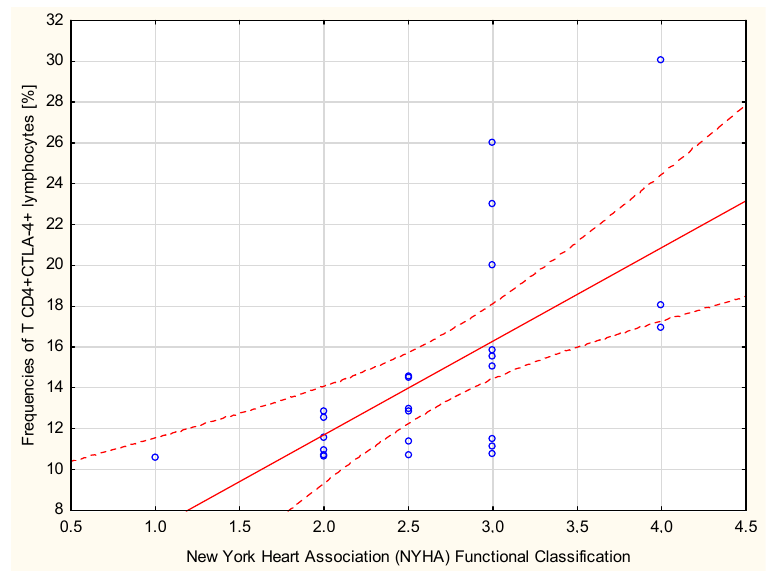
Figure 7. T CD4+CTLA4+ cells [%] and New York Heart Association (NYHA) Functional Classifica- tion; Spearman’s rank correlation r = 0.7077, p < 0.001. Moreover, the percentage of B CD19+CTLA-4+ cells strongly positively correlated with the concentration of NT-proBNP (r = 0.8498, p < 0.001, Figure 8).